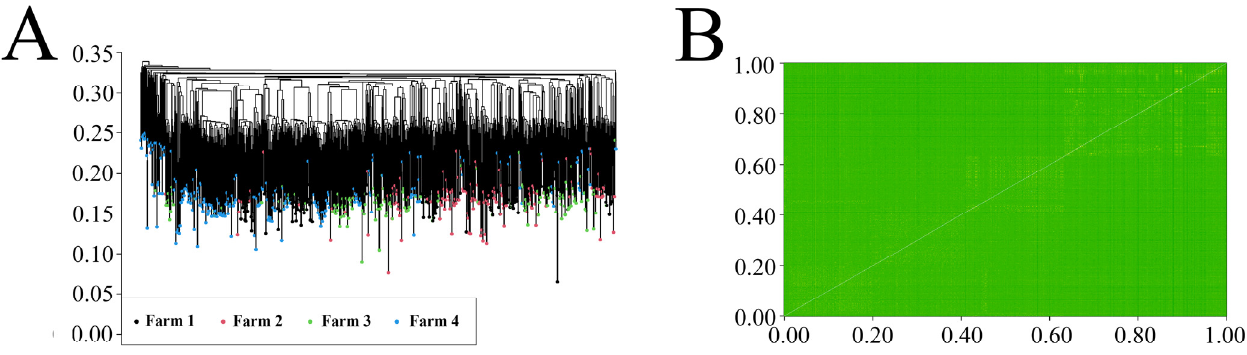
Figure 4. Population cluster analysis and IBS analysis: ( A ) cluster analysis; ( B ) IBS analysis.